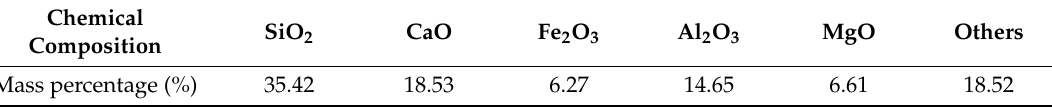
Table 2. The chemical composition of full tailings.